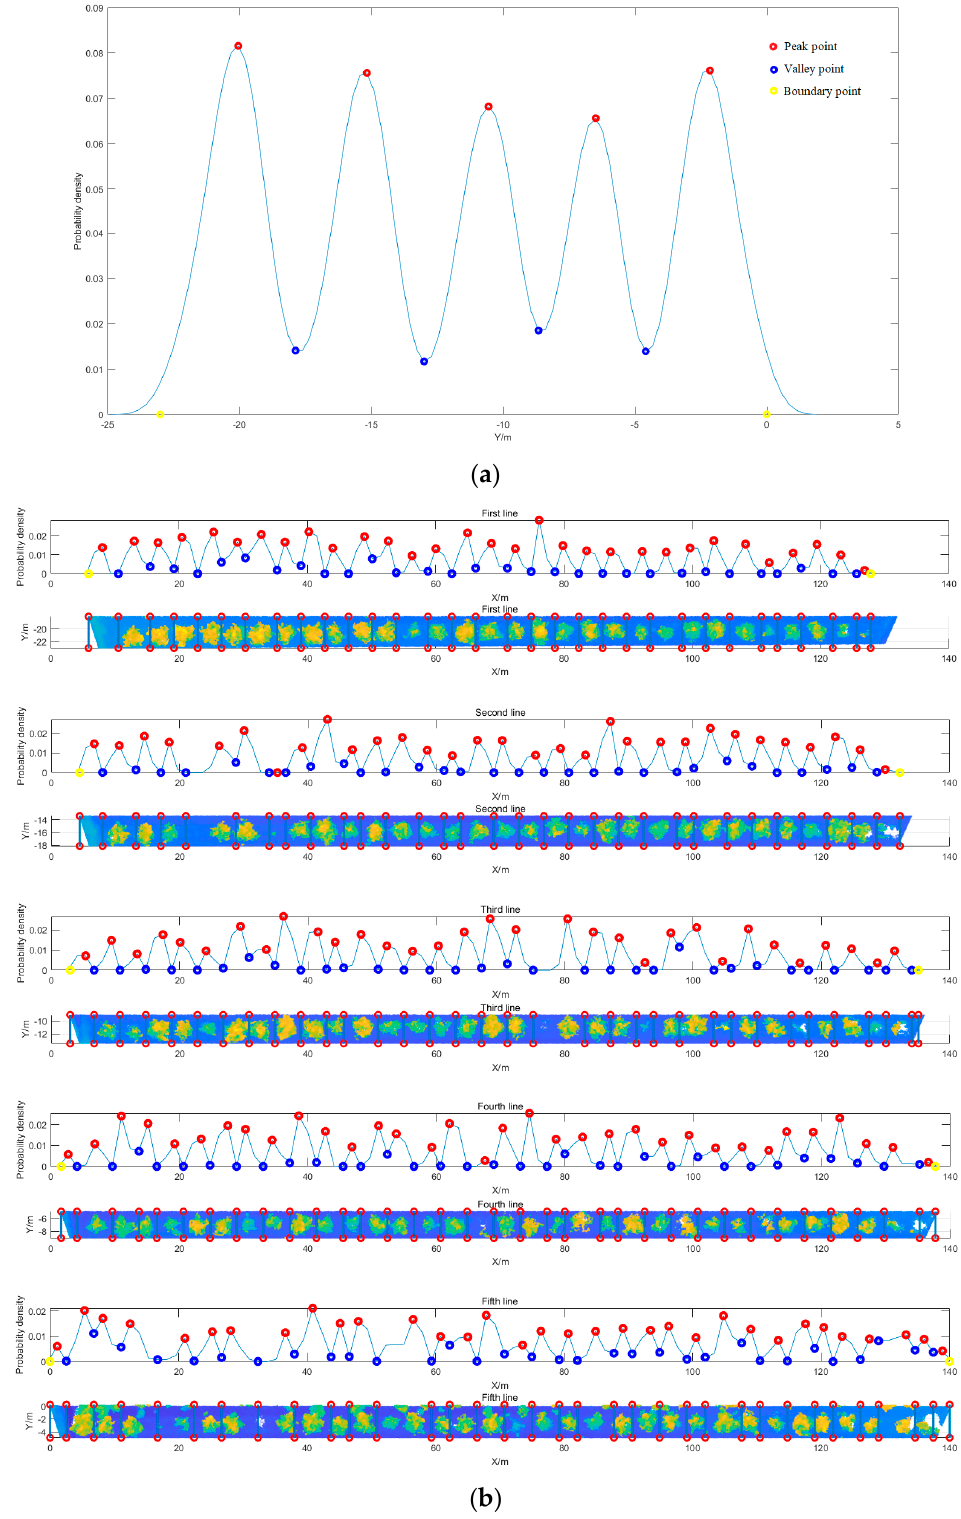
Figure 5. Row and column detection of the orchard point-cloud model. ( a ) Point-cloud probability density estimation of rows; ( b ) Point-cloud probability density estimation of columns.